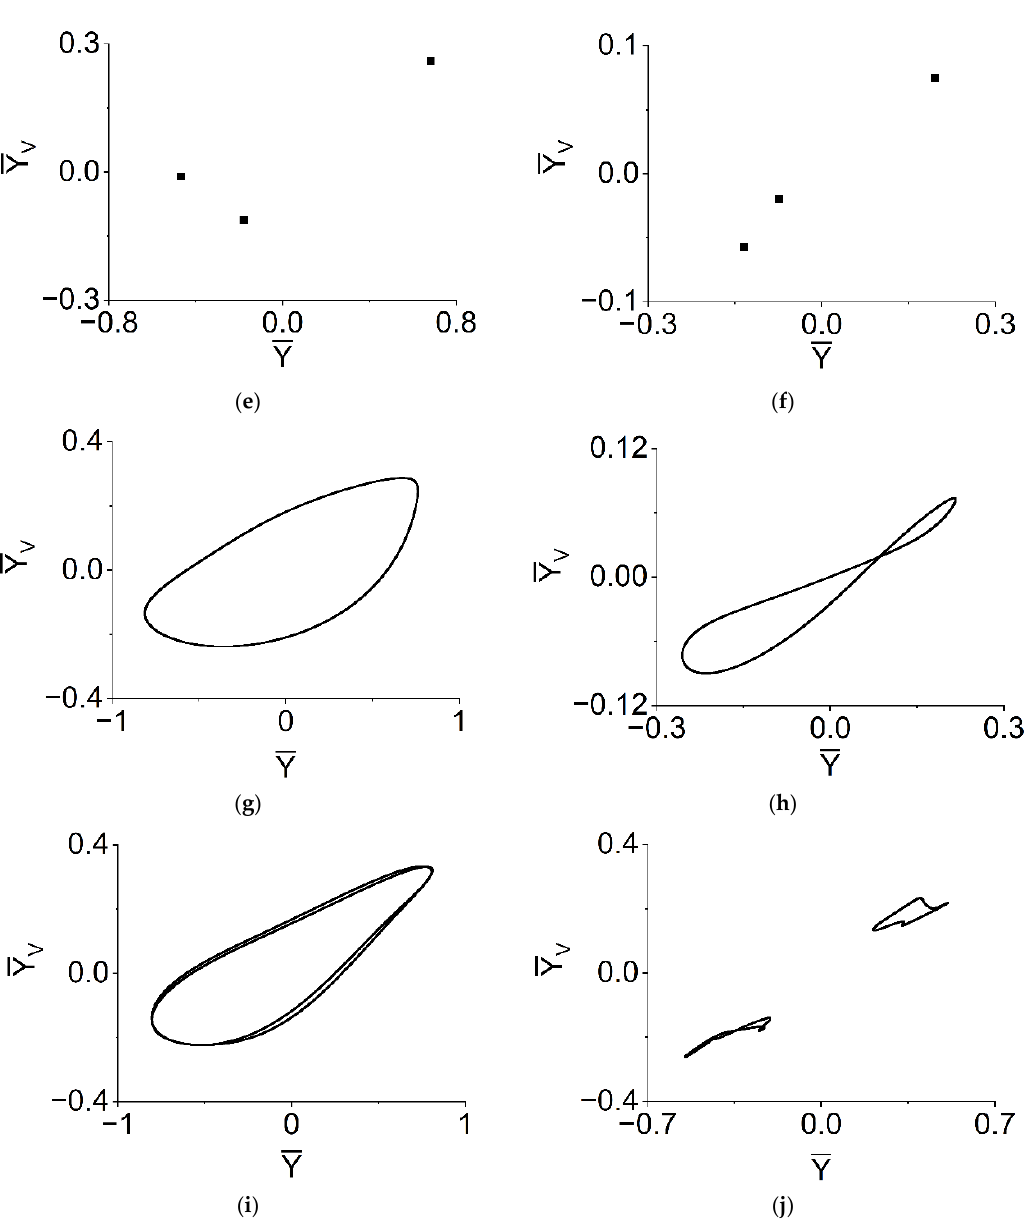
Figure 16. Poincaré maps of rotor system. ( a ) Rotor with Ω = 300 rad/s, ( b ) Bearing with Ω = 300 Figure 16. Poincar é maps of rotor system. ( a ) Rotor with Ω = 300 rad/s, ( b ) Bearing with rad/s, ( c ) Rotor with Ω = 880 rad/s, ( d ) Bearing with Ω = 880 rad/s, ( e ) Rotor with Ω = 1250 rad/s, ( f ) Ω = 300 rad/s, ( c ) Rotor with Ω = 880 rad/s, ( d ) Bearing with Ω = 880 rad/s, ( e ) Rotor with Bearing with Ω = 1250 rad/s, ( g ) Rotor with Ω = 1330 rad/s, ( h ) Bearing with Ω = 1330 rad/s, ( i ) Ro- Ω = 1250 rad/s, ( f ) Bearing with Ω = 1250 rad/s, ( g ) Rotor with Ω = 1330 rad/s, ( h ) Bearing with tor with Ω = 1400 rad/s, ( j ) Bearing with Ω = 1400 rad/s Ω = 1330 rad/s, ( i ) Rotor with Ω = 1400 rad/s, ( j ) Bearing with Ω = 1400